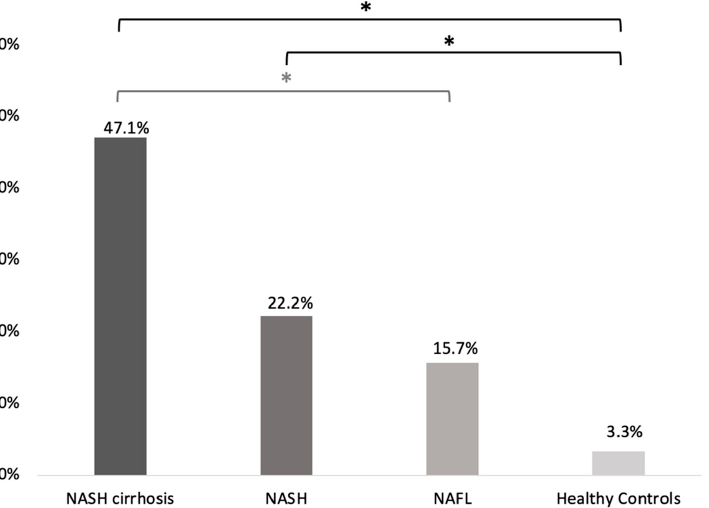
Figure 2. SIBO prevalence among patients with different stages of NAFLD and healthy controls. SIBO: small intestinal bacterial overgrowth; NAFL: non-alcoholic fatty liver; NASH: non-alcoholic steatohepatitis. * denotes statistical significance.